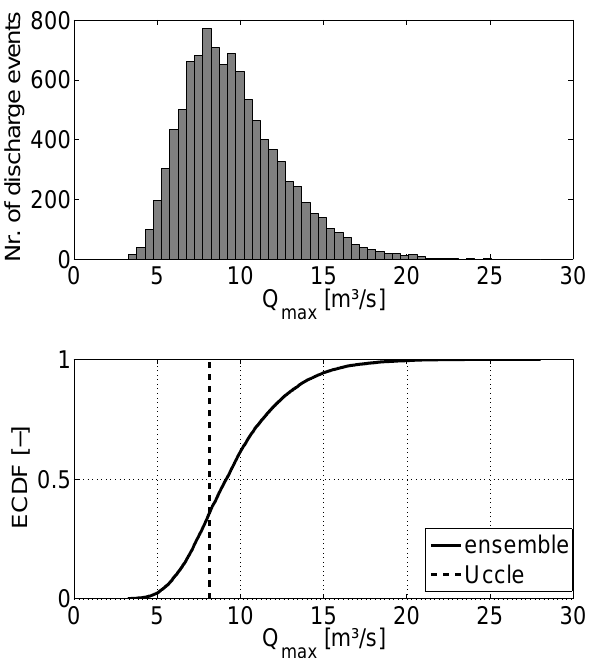
Fig. 10. The set of randomly generated design storms is able to give an idea of the distribution of the maximum peak discharge Q max . The maximum peak discharge for the historical 2nd-quartile summer storm on which the set is based clearly falls within the range of the distribution.